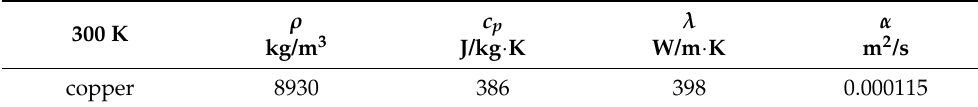
Table 2. Physical properties of